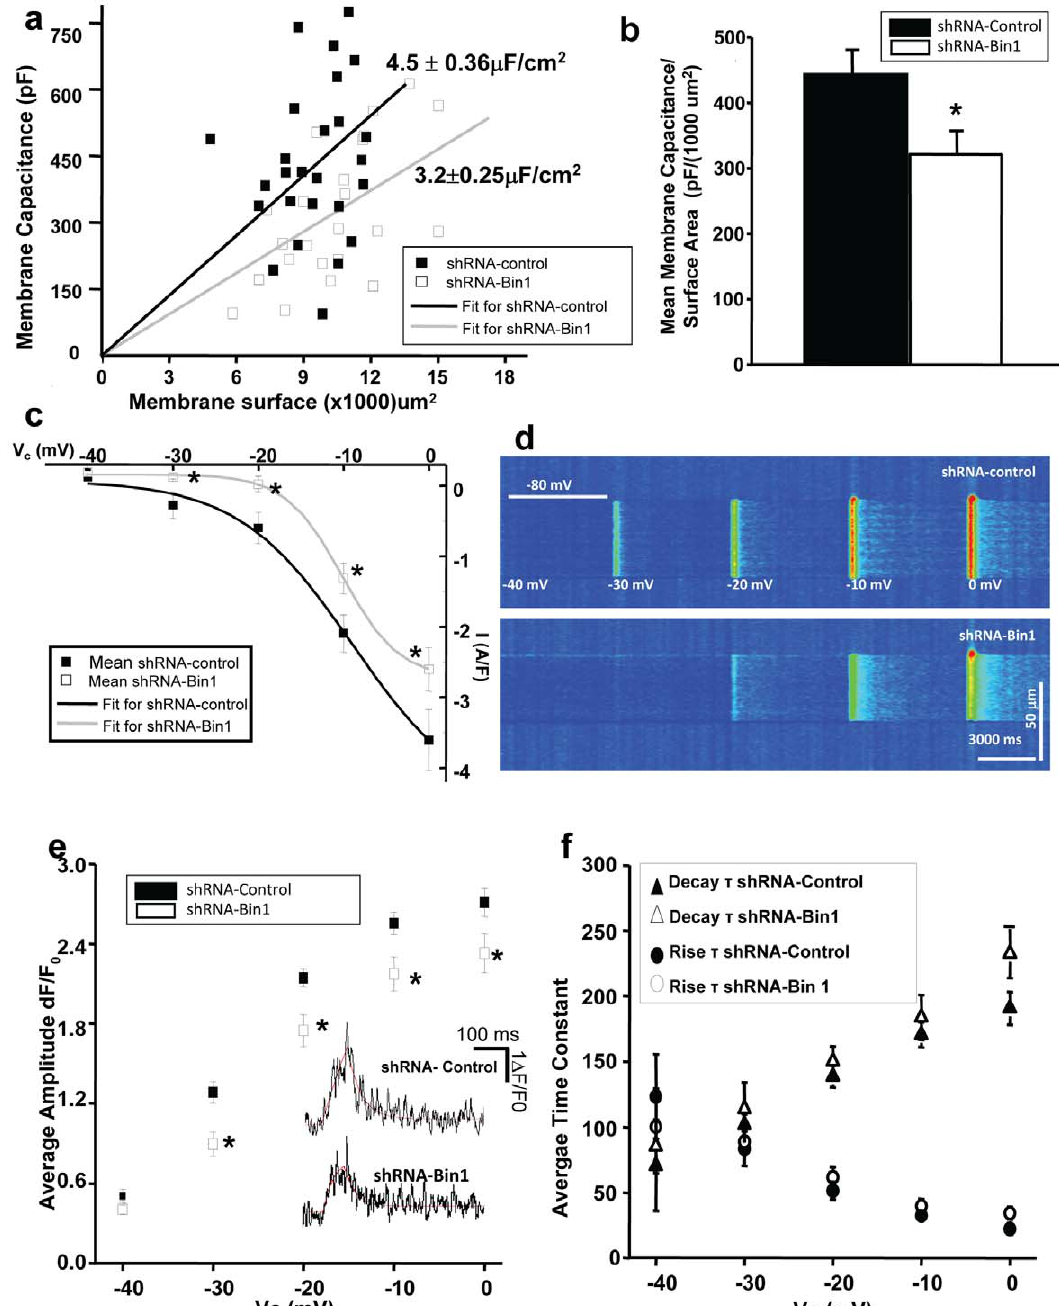
Figure 3. Inefficient voltage induced Ca 2 + release (VICR) in shRNA-Bin1 muscle. (a) Measured membrane capacitance as a function of the estimated surface membrane area of the silicone-free surface area the fiber. The capacitance was measured by integrating the current transient obtained from 10 mV voltage pulse. Each symbol in the graph corresponds to different fibers, with filled box as shRNA-control and empty box as shRNA-Bin1. Data points, obtained in the same fiber, were fitted to a straight line to zero following the method described by Jacquemond, et al [23] with black line represents the shRNA-control and gray line represents shRNA-Bin1 fibers. (b) Quantification of reduced mean membrane capacitance/ surface area in the shRNA-Bin1 (blank square) when compared to shRNA-control fibers (filled square). (c) The voltage-current relationship (IV) from depolarizing pulses of 2 40 mV to 0 mV was fitted following sigmoidal fit with black line representing shRNA-control and gray line representing shRNA- Bin1. Altered mean current amplitude in the shRNA-Bin1 (blank square) when compared to shRNA-control fibers (filled square). (d) Representative Fluo- 4 fluorescence trace during different depolarizing pulses ranging from 2 40 mV to 0 mV for 200 ms with 10 mV increment from an initial holding voltage of 2 80 mV. Between pulses the membrane was returned to 2 80 mV as indicated by the white horizontal bar. The difference of Ca 2 + transient amplitude after depolarizing stimuli was evident even at 2 30 mV stimulation. (e) shRNA-Bin1 (n=26 fibers, blank square) continuously displayed reduced mean amplitude Ca 2 + release when compared to shRNA-control (n=22 fibers, filled square) at different depolarizing pulses ranging from -40 to 0 mV. Representative trace of Ca 2 + release amplitude (dF/F 0 ) and kinetic (D 50 ) ( inset ). (f) Mean rise (circle) and decay (triangle) t for both shRNA- control and shRNA-Bin1 fibers were fitted exponentially. No significant differences, however, were observed in these two groups.